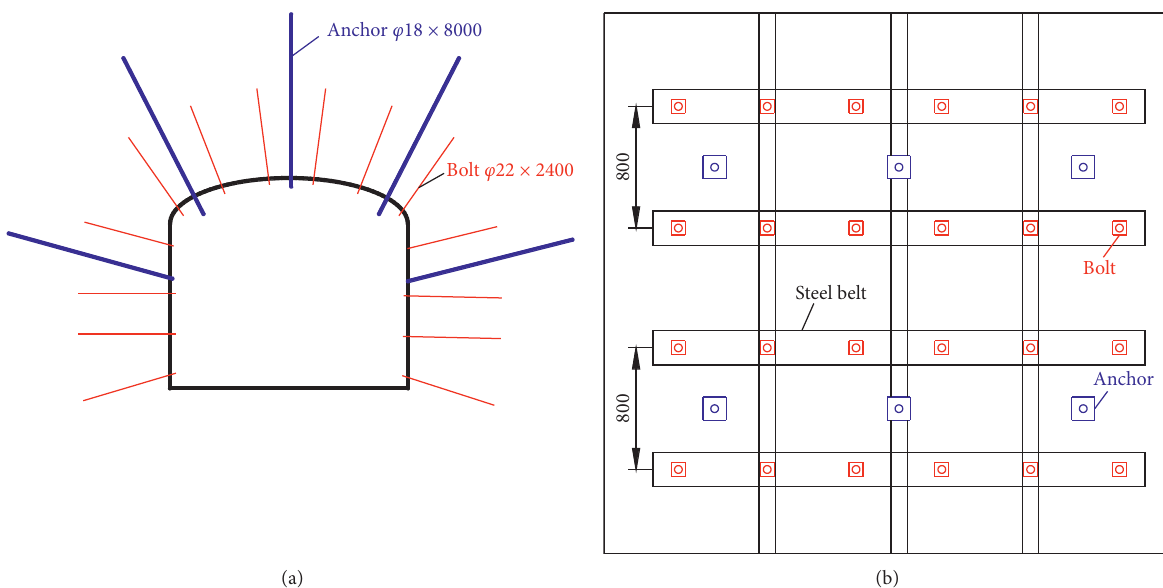
Figure 2: Original support form of the 3307 ventilation roadway. (a) Front view of original support form of the roadway. (b) Top view of original support form of the